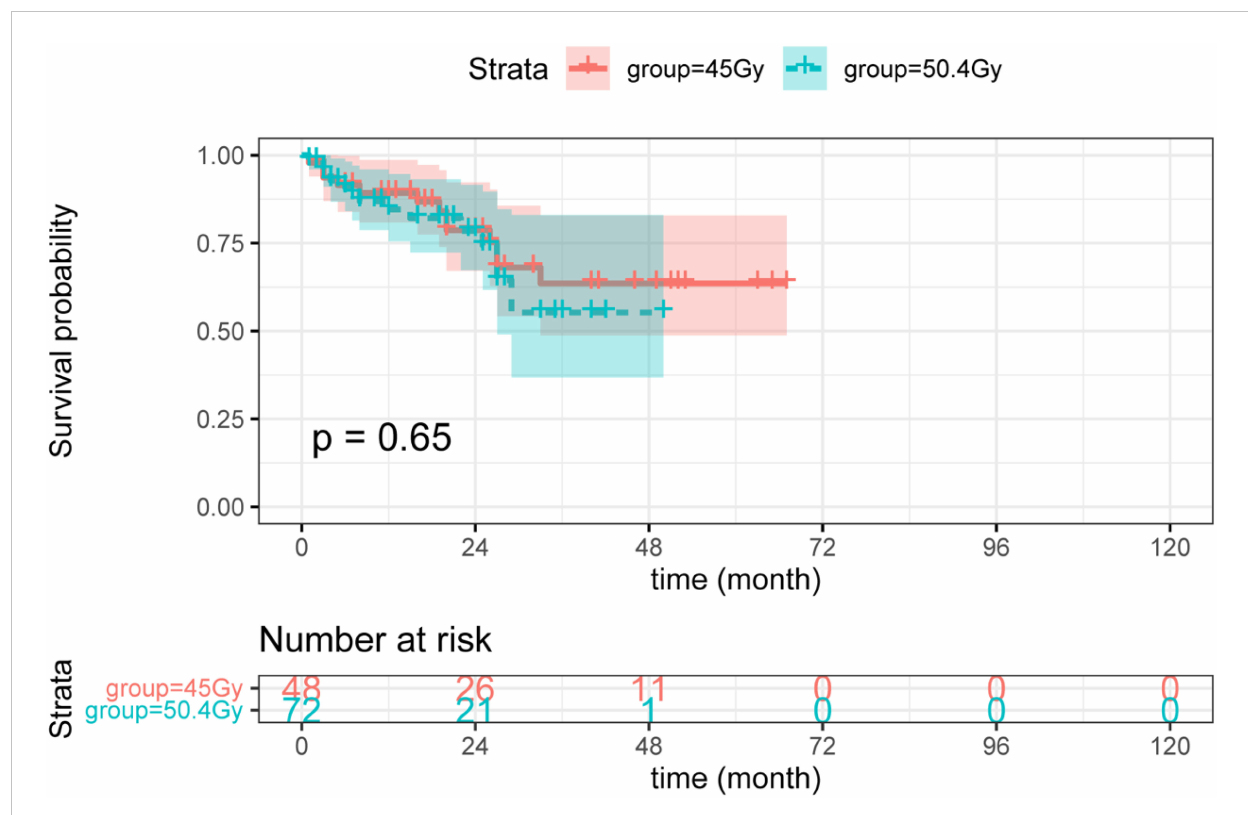
FIGURE 3 The DFS between LARC patients with different radiation doses. DFS, disease-free survival; LARC, locally advanced rectal